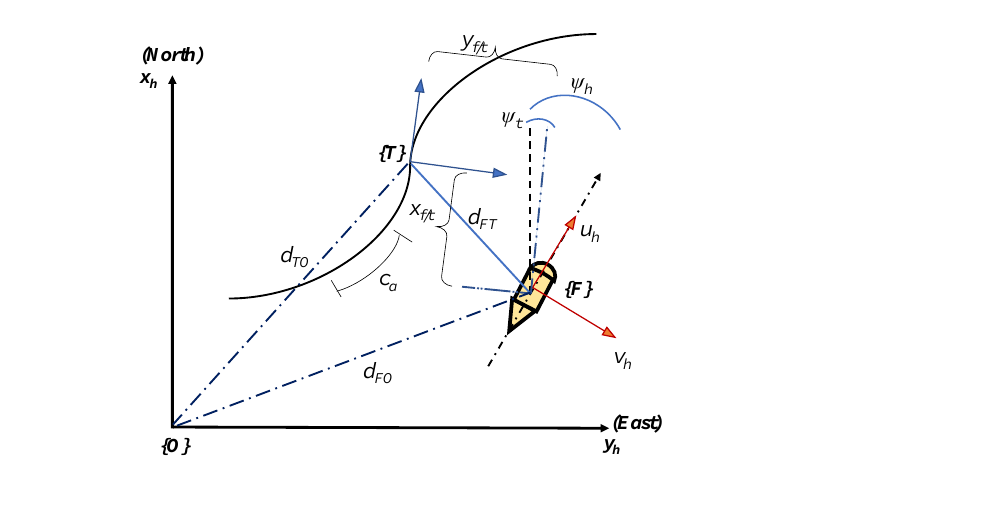
Figure 4. Description of S-F Frame in steering